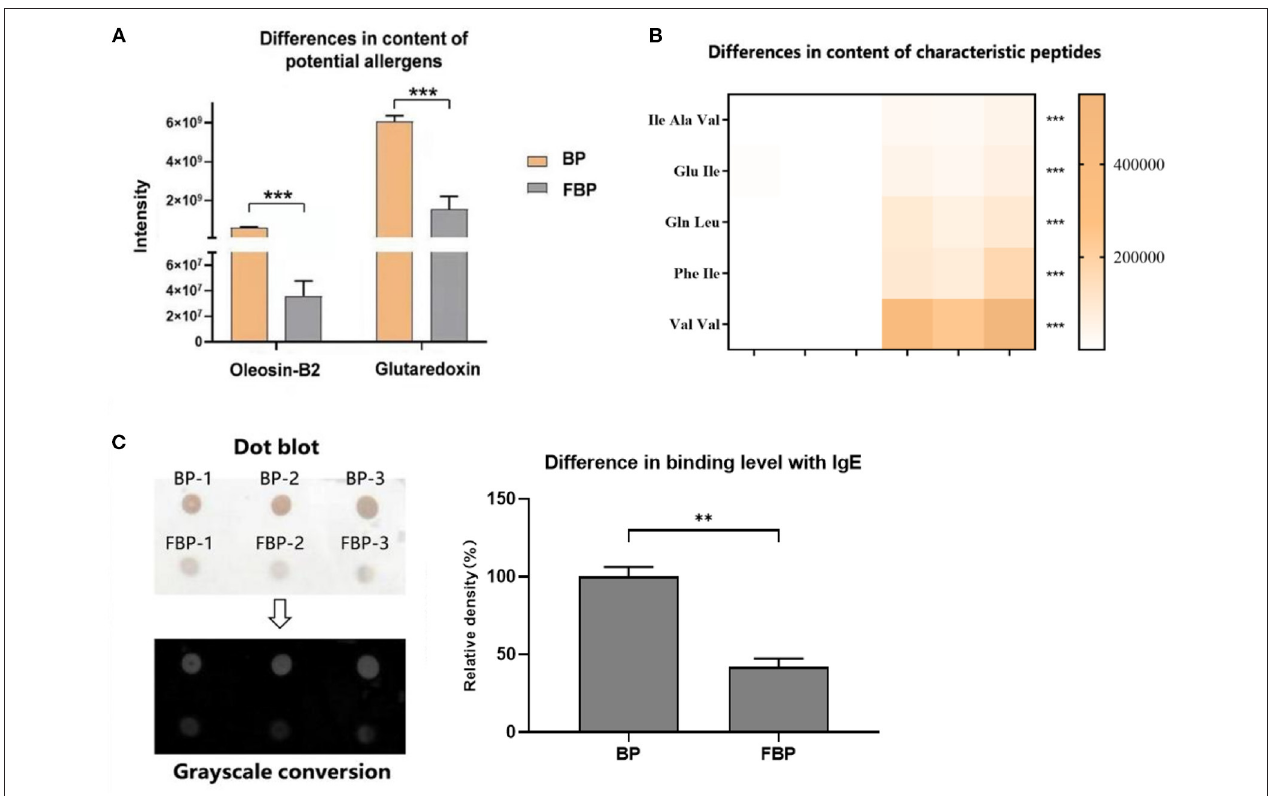
FIGURE 4 | (A) Differences in the content of potential allergens of B. napus bee pollen before and after fermentation by S. cerevisiae . BP means the unfermented B. napus bee pollen, and FBP means the S. cerevisiae fermented B. napus bee pollen. (B) Differences in the content of characteristic oligopeptides in bee pollen before and after fermentation. The color bar from blank to yellow represented the level of five oligopeptides from low to high in the bee pollen. (C) Difference in the binding level of B. napus bee pollen protein with human native immunoglobulin E (IgE) before and after fermentation detected using Dot-blot method. Three repeated experiments were conducted. The symbol of **means P < 0.01, and ***means P <